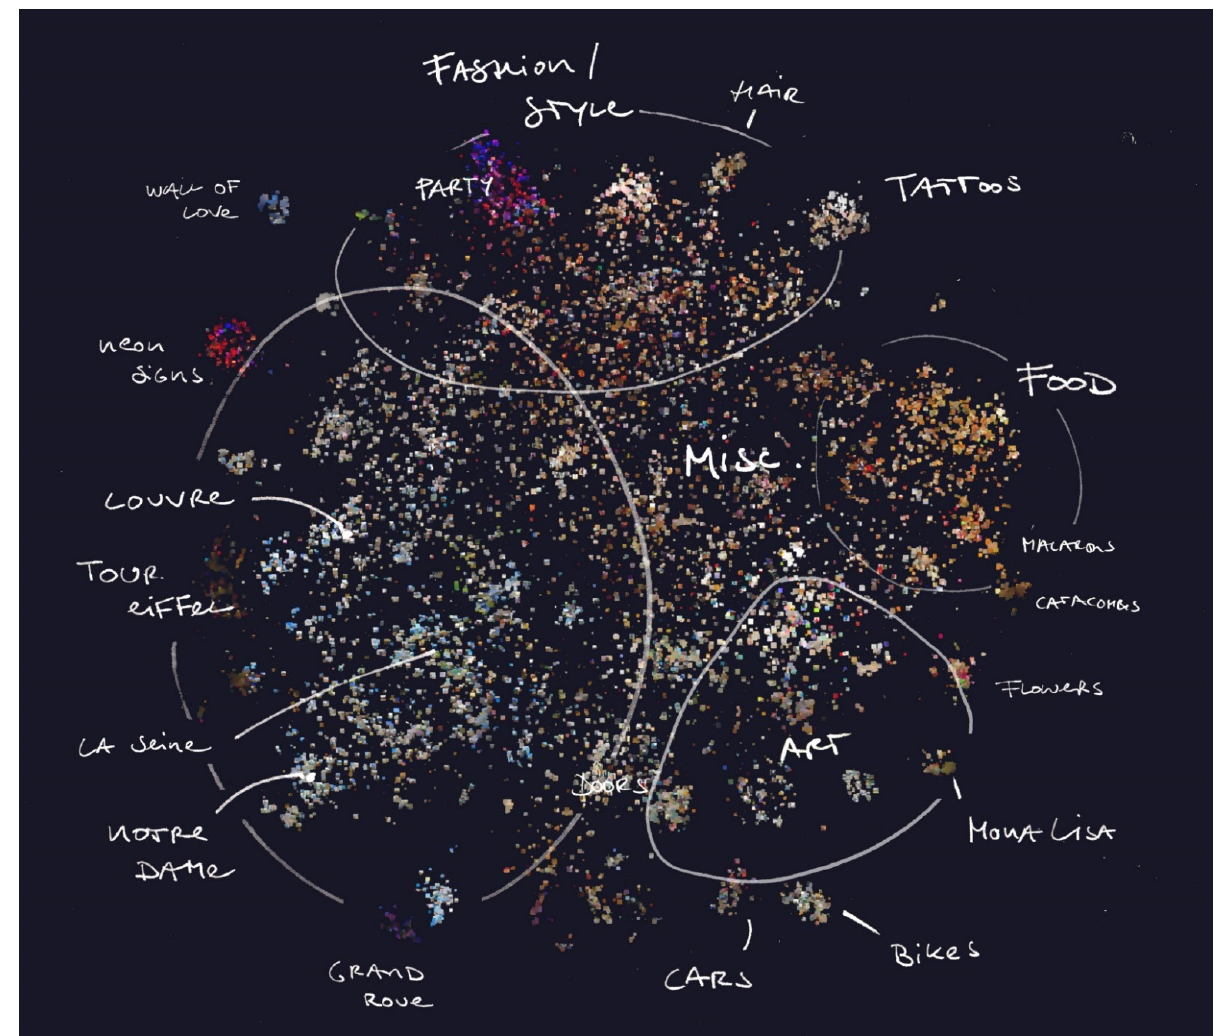
Figure 11. Paris’ image clusters. Topic’s clusters are manually identified by the artist. Moritz Stefaner. Multiplicity ( 1 2 3 data exhibition, 2017). Available on: https://truth-and-beauty.net/projects/multiplicity (accessed on 28 July 2022).